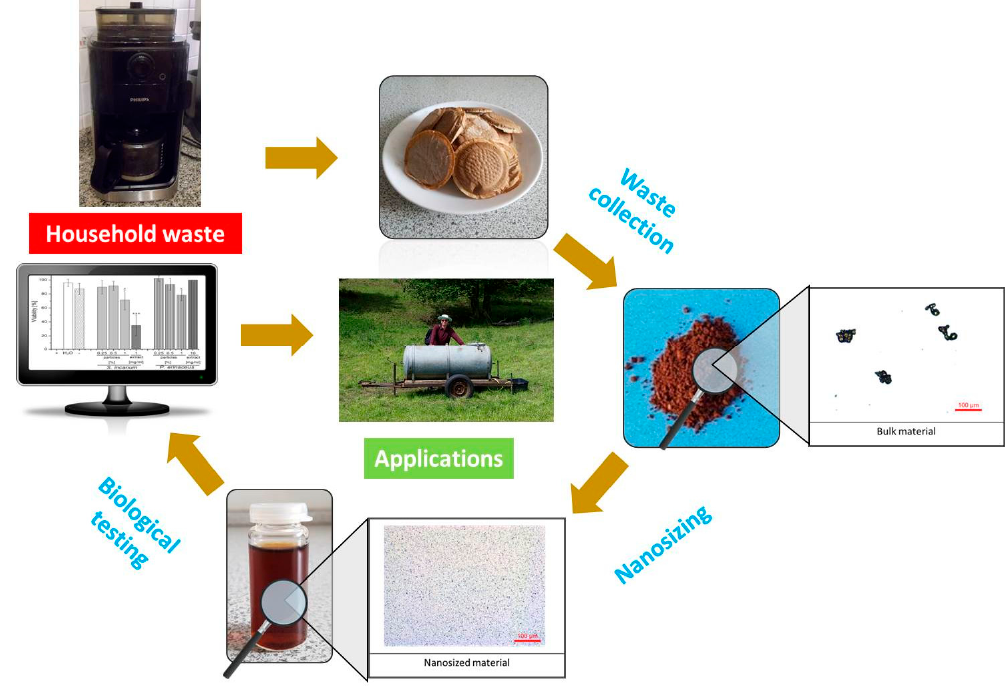
Figure 7. A schematic overview of theutilization of nanosizing techniques for turning waste into value.